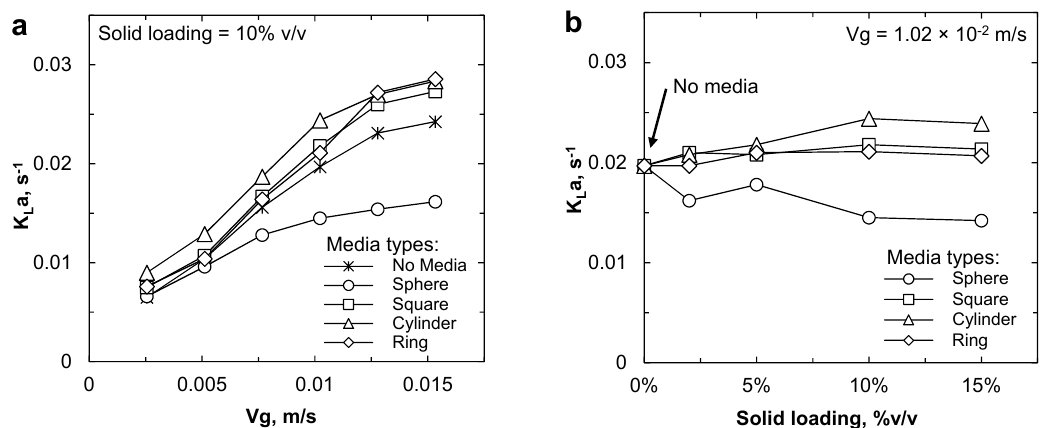
Figure 8. Overall mass transfer coefficient (K L a) in the riser compartment of ALR for each solid media type with: ( a ) superficial gas velocity (Vg) and ( b ) solid loading.